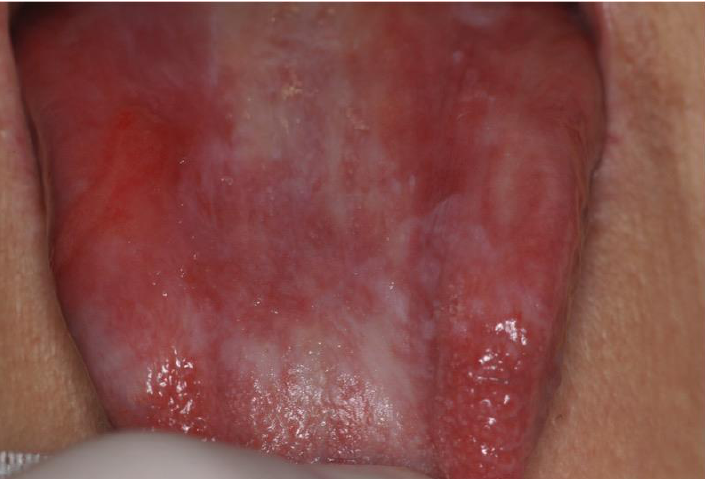
Figure 1. Keratotic plaque lesions on the lingual dorsum associated with severe atrophy and micro- ulcerations in a patient affected by oral cGVHD.